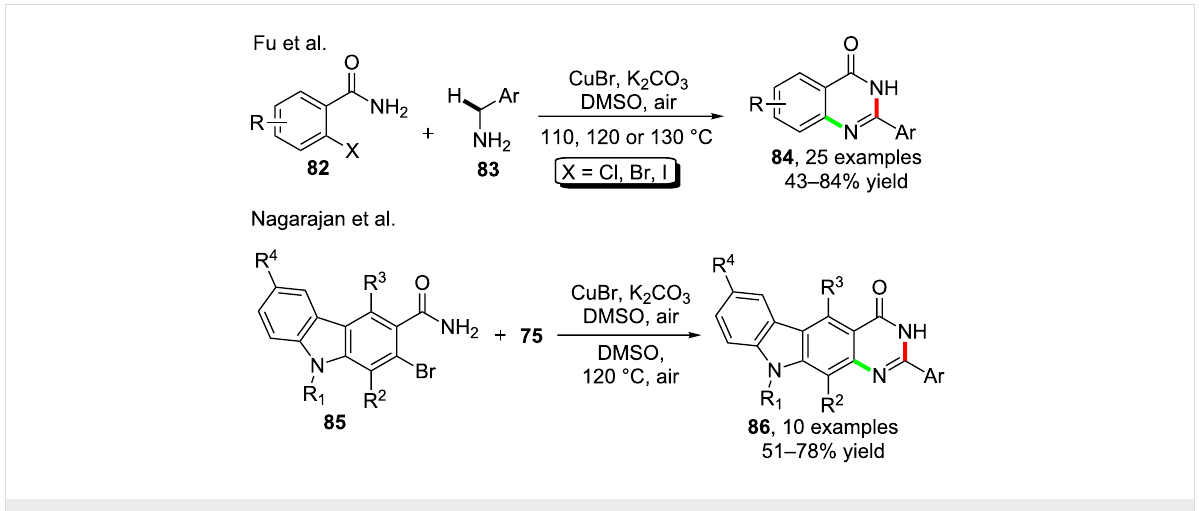
Scheme 22: Copper-catalyzed cascade reaction for the synthesis of